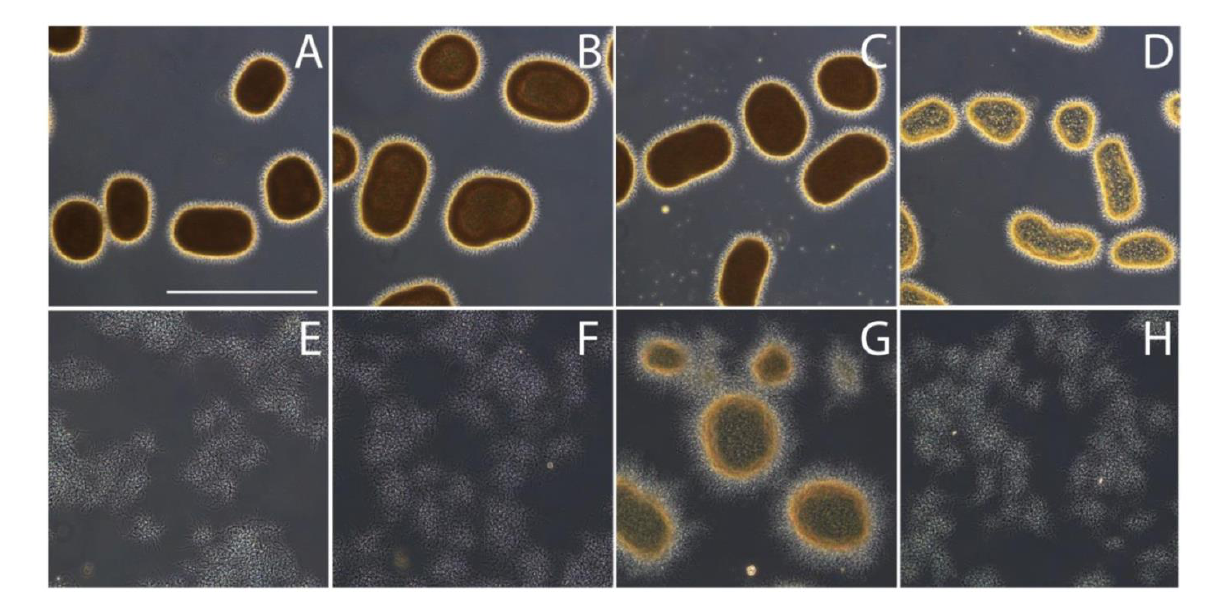
FIGURE 5: Effect of cellulases and dispersin B on mycelial morphology . Light micrographs show S. lividans 66 (A) , S. lividans 66 treated with 2 U/ml cellulase (B) , 100 µg/ml dispersin B (C) or both cellulase and dispersin B (D) , the matB (E) and cslA mutants (F) and the cslA mutant harboring pMAT7 without (G) or with (H) added dispersin B. All strains were grown in TSBS medium for 24 h at 30 o C. The effects on mor- phology were visualized by wide-field microscopy. Bar, 500